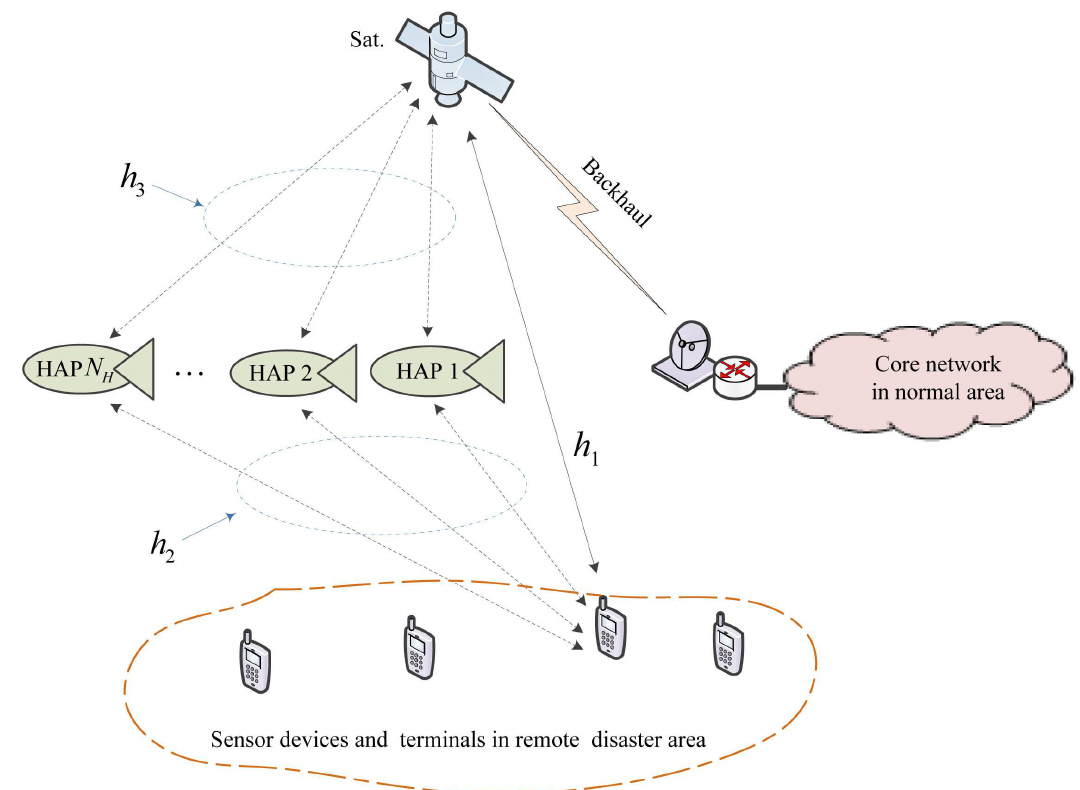
Figure 1. System model of the integrated high altitude platform (HAP)/satellite (IHS) network for emergency